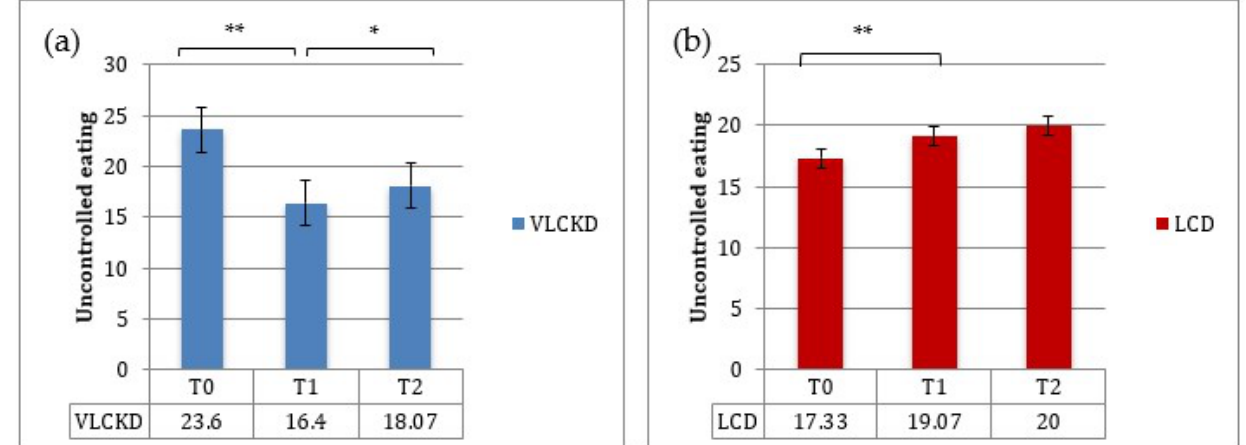
Figure 5. Mean scores (±SE) for uncontrolled eating at baseline, T1 and T2: ( a ) VLCKD group; ( b ) LCD group. * p < 0.05; ** p < 0.001.